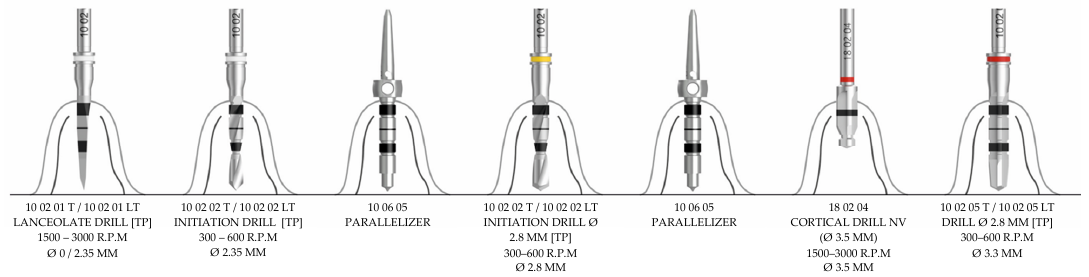
Figure 1. Preparation technique for the 3.5 mm diameter implants.